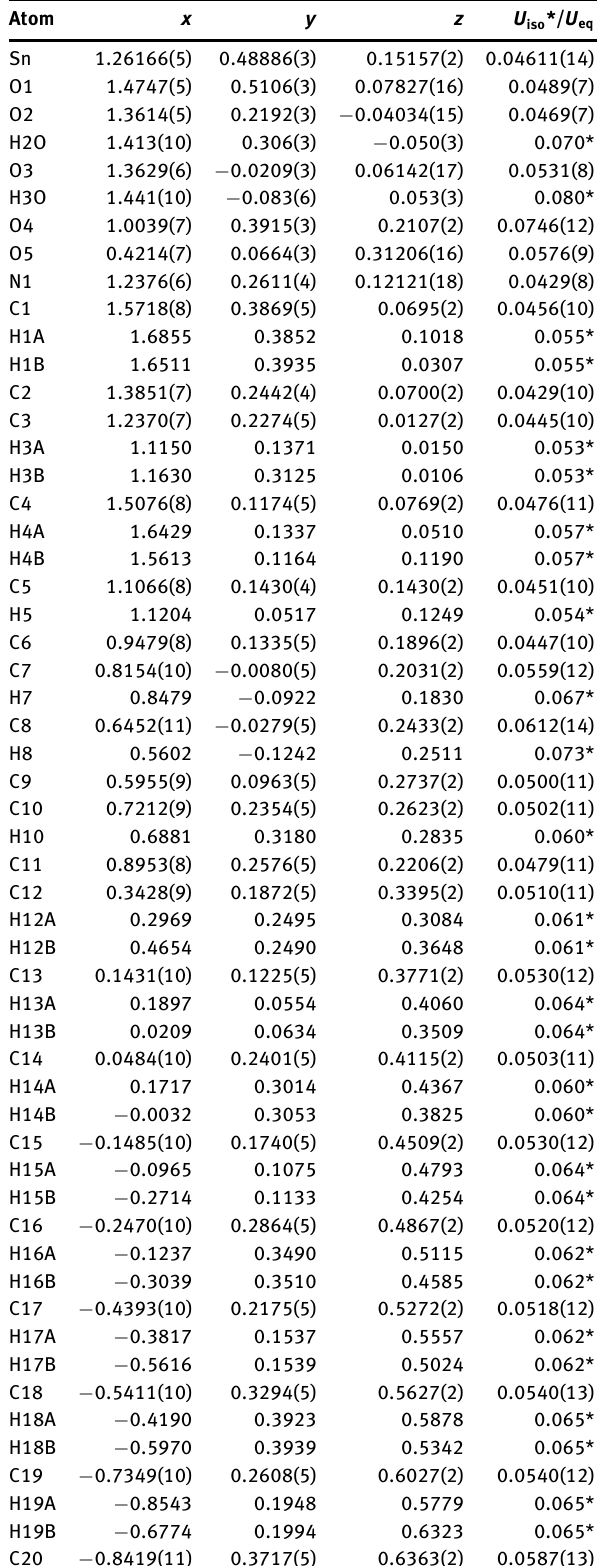
Table 2: Fractional atomic coordinates and isotropic or equivalent isotropic displacement parameters (Å 2 ).